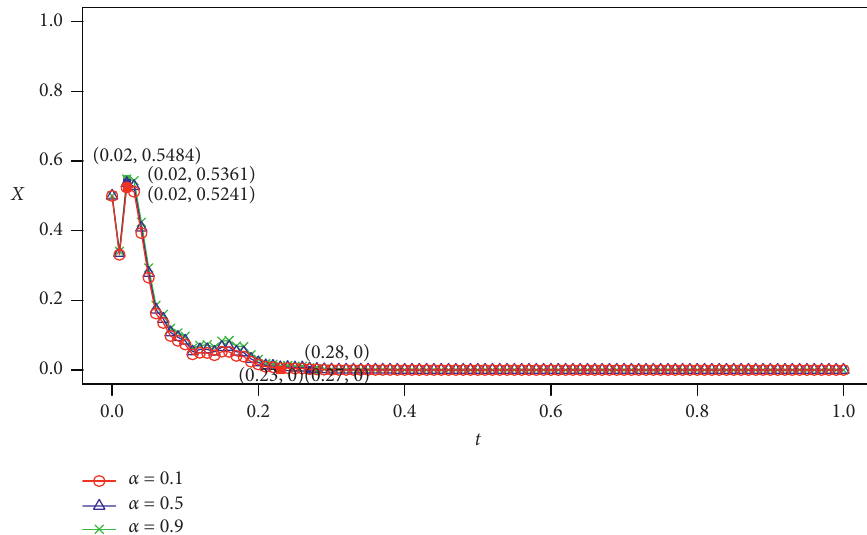
Figure 1: The impact of tax reduction ratio α on local government’s strategy selection.